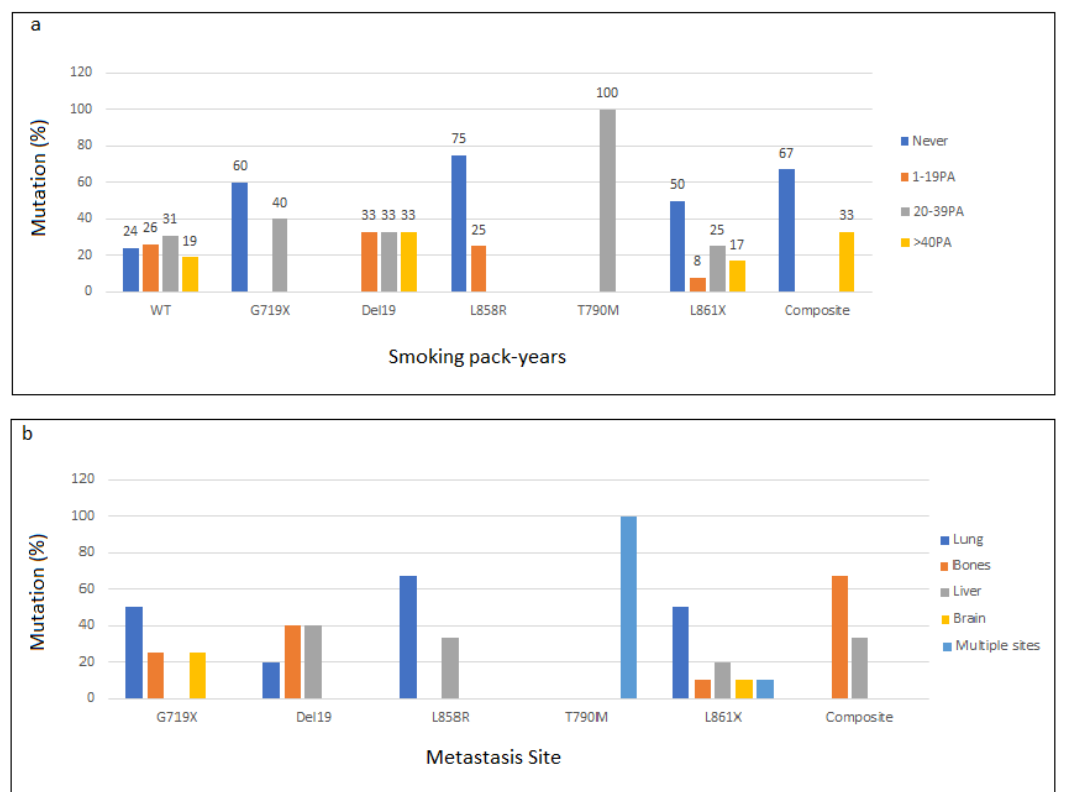
Figure 2. Distribution of EGFR mutation according to smoking status ( a ) and metastasis site ( b Figure 2: Distribution of EGFR mutation according to smoking status (a) and metastasis site (b) Table 4. Treatment response and survival of patients carrying EGFR mutations.